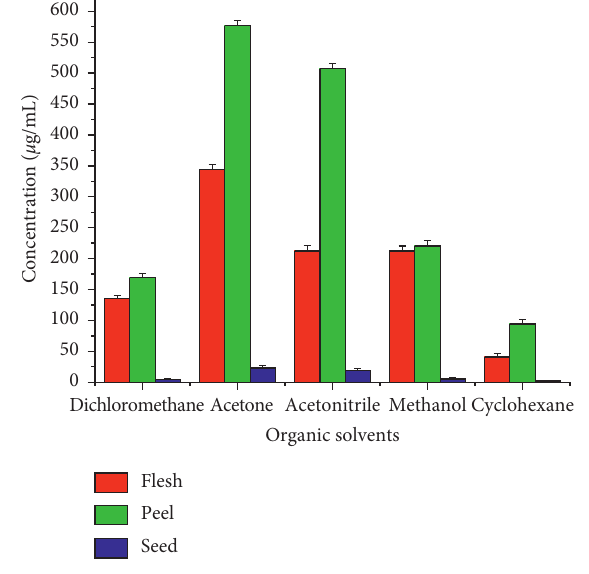
Figure 3: Results of efficiency of five extraction solvents (dichloromethane, acetone, methanol, acetonitrile, and cyclohex- ane) in pumpkin flesh, peel, and seed samples based on UV-VIS absorption